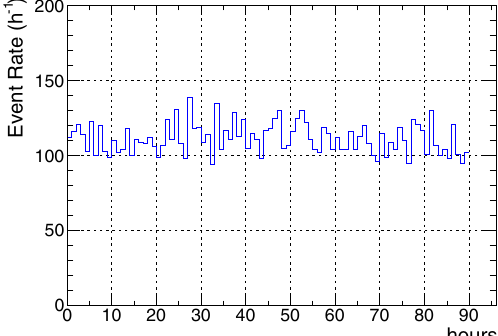
Fig. 3 Time-variations of the event rate during the 90 h-long run at (cid:2) T ∼= 6 ◦ C many other examined test runs, demonstrating that the data acquisition dead time is independent of the event rate, as for example shown in Fig. 5 for a run performed using the AmBe ∼ = source at (cid:2) T 6 . 5 ◦ C.